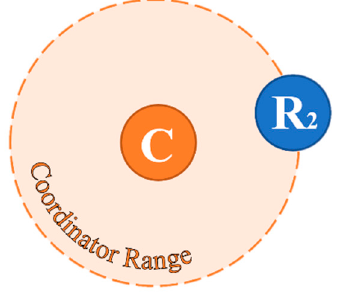
Figure 11. Representation of Case A.2.